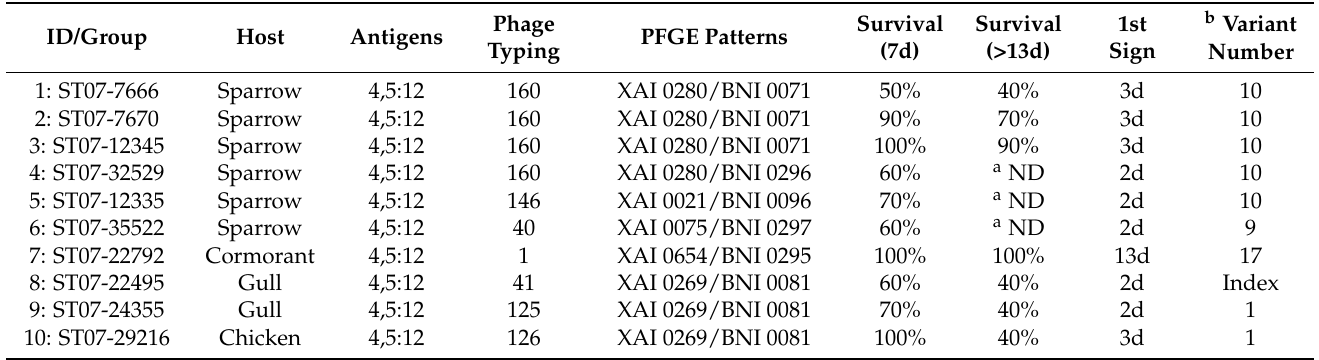
a ND: not determined. b AmpliSeq tool results: variant number represents each instance of sequence variation among the virulence genes as detected following the mapping of the amplicon reads to the Salmonella Typhimurium reference genome.